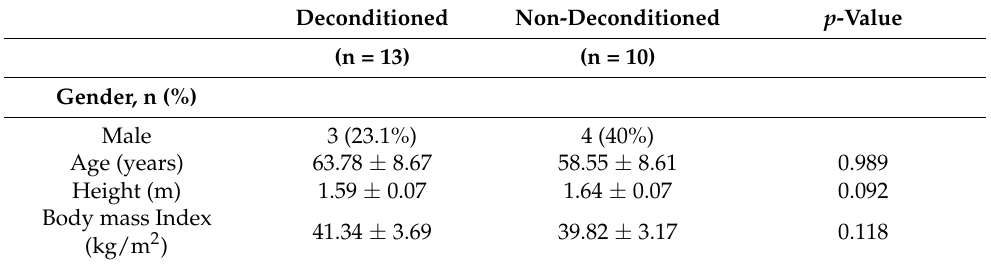
Table 1. Participant